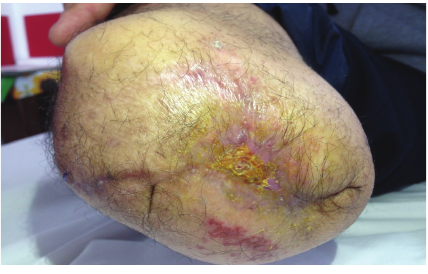
Figure 6: Stage VI at 6th week.